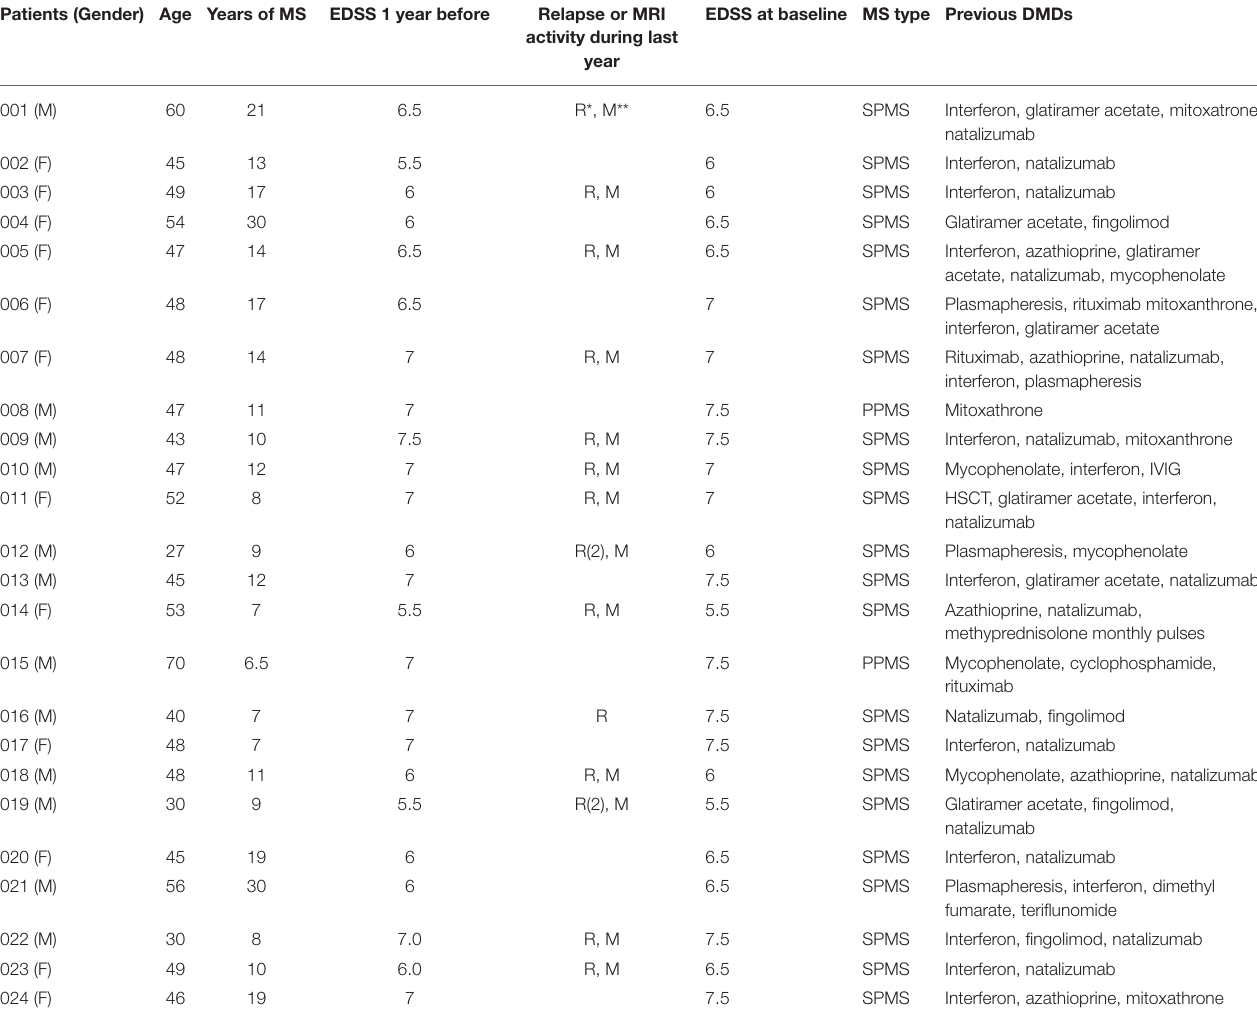
TABLE 1 | Demographics of the patients. Patients (Gender) Age Years of MS EDSS 1 year before Relapse or MRI